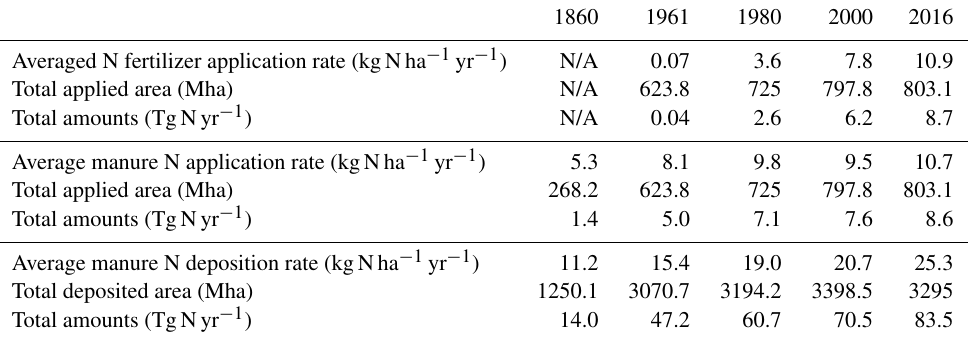
Table 1. The N input rates, applied/deposited area and total amounts in global pastures and rangelands in 1860, 1961, 1980, 2000 and 2016 (1km 2 = 100ha). N/A: not